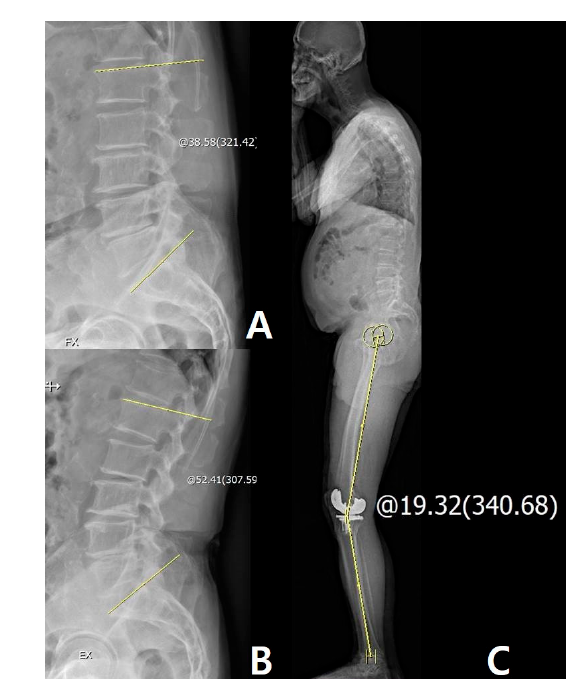
Figure 5. Patients with lesser LF have disparities in the knee joint between passive extension and real standing extension after TKA. ( A ) Measurement of LL on flexion view: 38.58°. ( B ) Measurement of LL on extension view: 52.41°. ( C ) Measurement of disparity is 19.32° with passive full extension. The yellow line and circle are the measurement about lumbar flexibility and sagittal HKA.